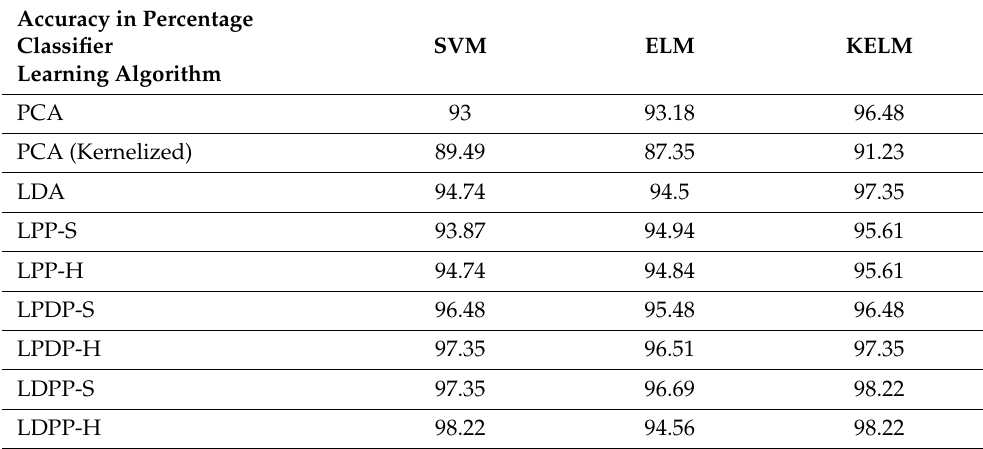
Table 2. Average performance characteristics of classifiers used in conjunction with subspace projec- tion learning algorithms over multi-beverage identifier e-tongue data